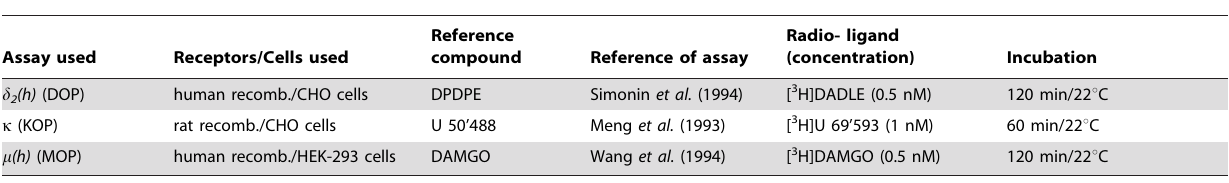
Table 2. In vitro opioid receptor-displacement